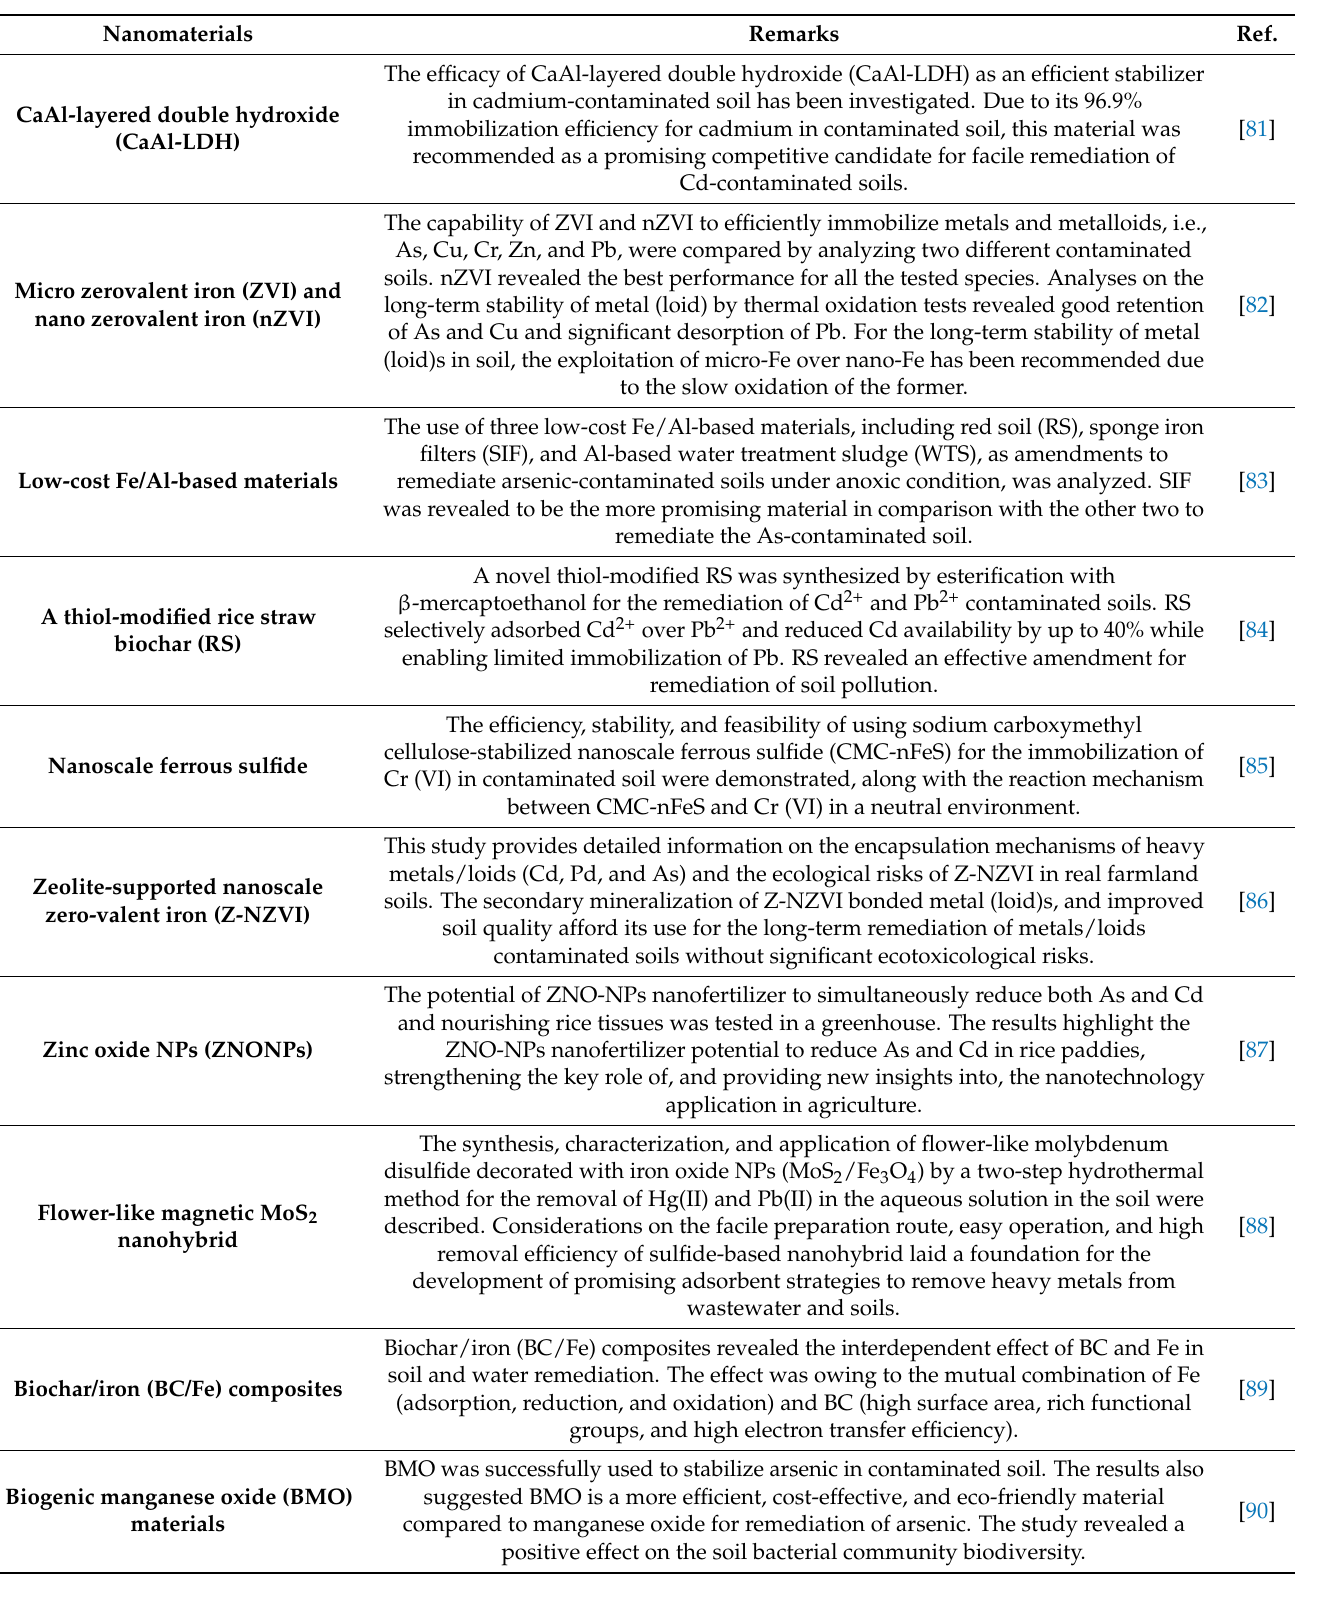
Table 3. Latest innovations regarding nano-enabled materials for soil